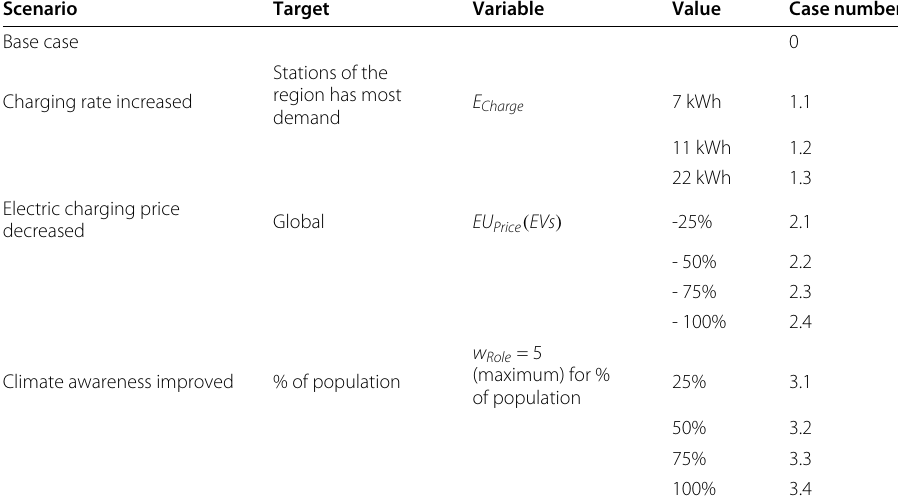
Table 2 Scenarios and their modified